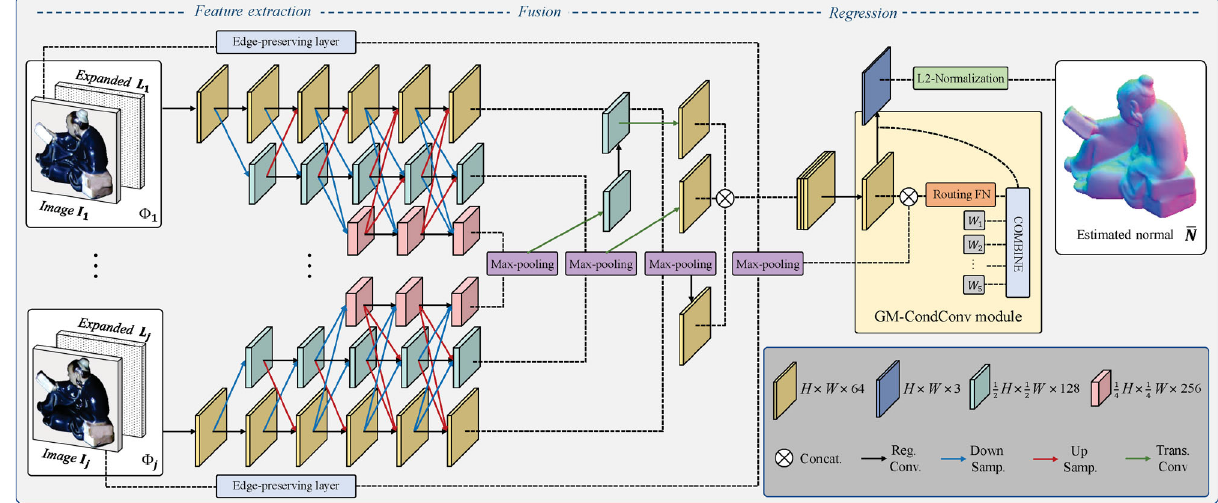
Fig. 1 Architecture of our CHR-PSN. Reg. Conv. = regular convolution, Down Samp. = down-sampling, Up Samp. = up-sampling, Trans. Conv = transposed convolution. Leaky-ReLU is the activation function for each layer. Our network has three stages, for feature extraction, fusion, and regression. Given an arbitrary number of images with different lighting directions, we first extract multi-scale features and represent the edge features. Multi-resolution max-pooling operations are applied for fusion. Finally, an improved GM-CondConv module infers surface